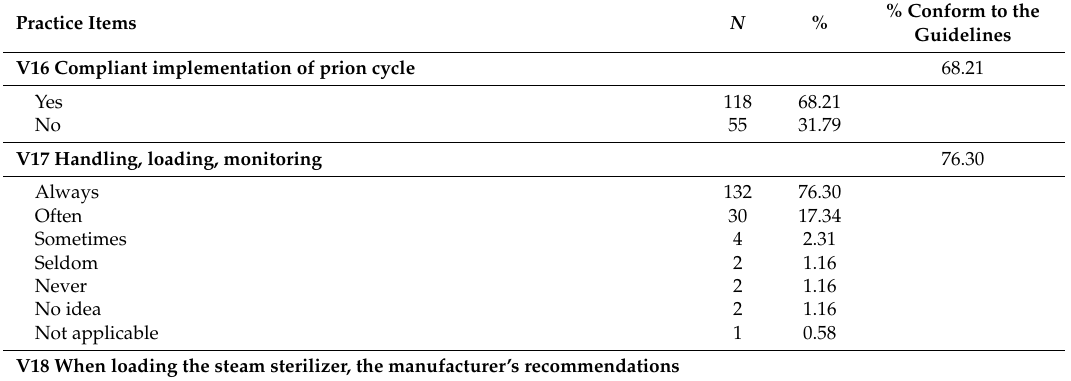
Table 3. Descriptive analysis: Autoclave performance and practitioner knowledge of autoclave use (Group 3) ( N =